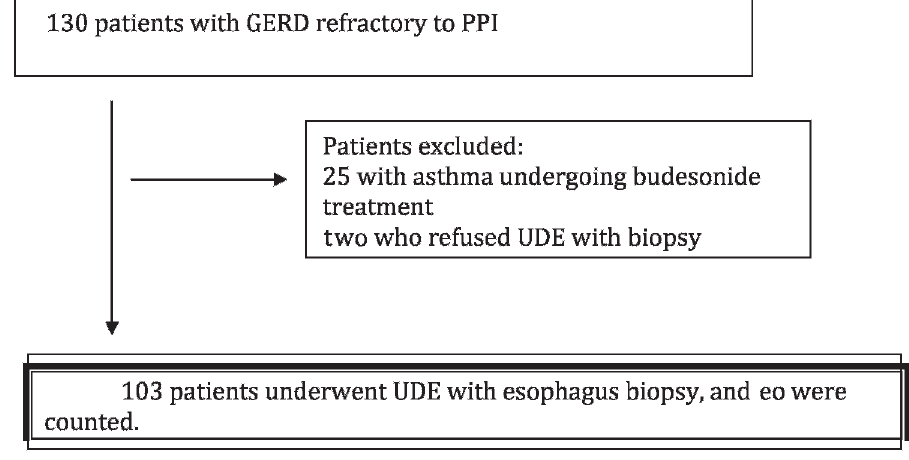
Figure 1 - Patient selection flowchart GERD: gastroesophageal reflux disease; PPI: proton pump inhibitor; UDE; upper digestive endoscopy;